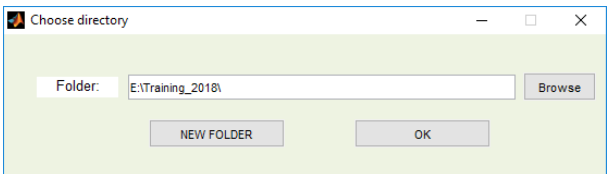
Figure 8. Window for selecting the working folder in order to store the generated information